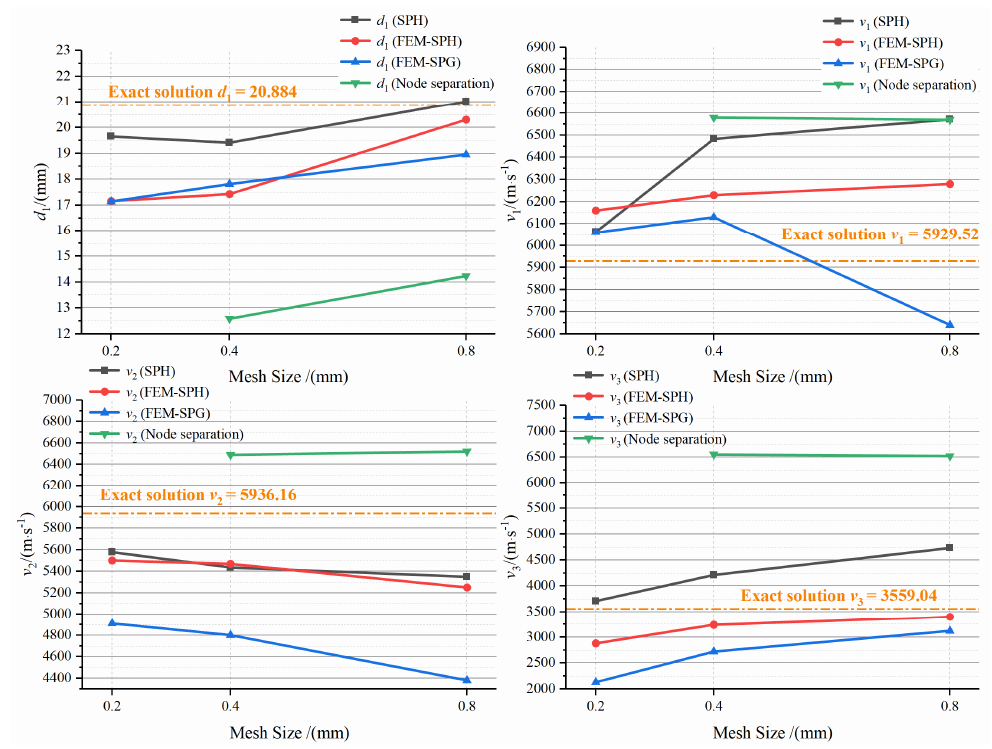
Figure 19. Comparison between the simulation results and the exact solutions of hypervelocity impact characteristic parameters.